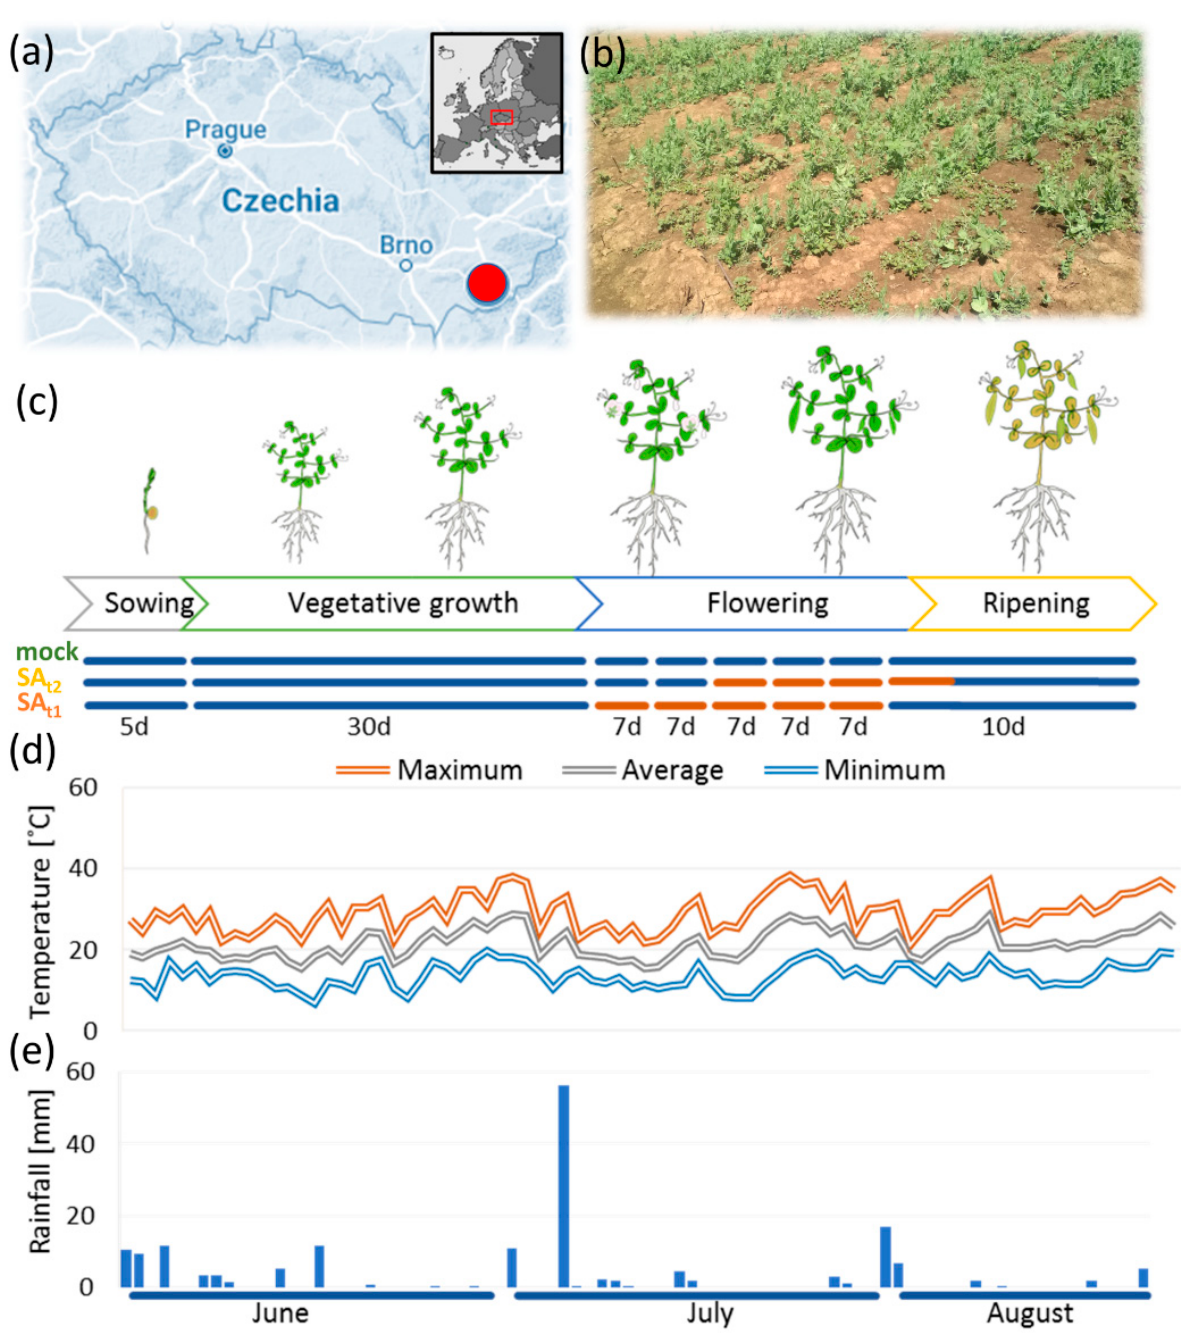
Figure 1. Experimental design. ( a ) Geographical location of the experimental field; ( b ) Field experi- ment, vegetative growth stage; ( c ) Experimental design. Orange blocks represent treatment with 100 µM salicylic acid; ( d , e ) Temperature and rainfall profile.